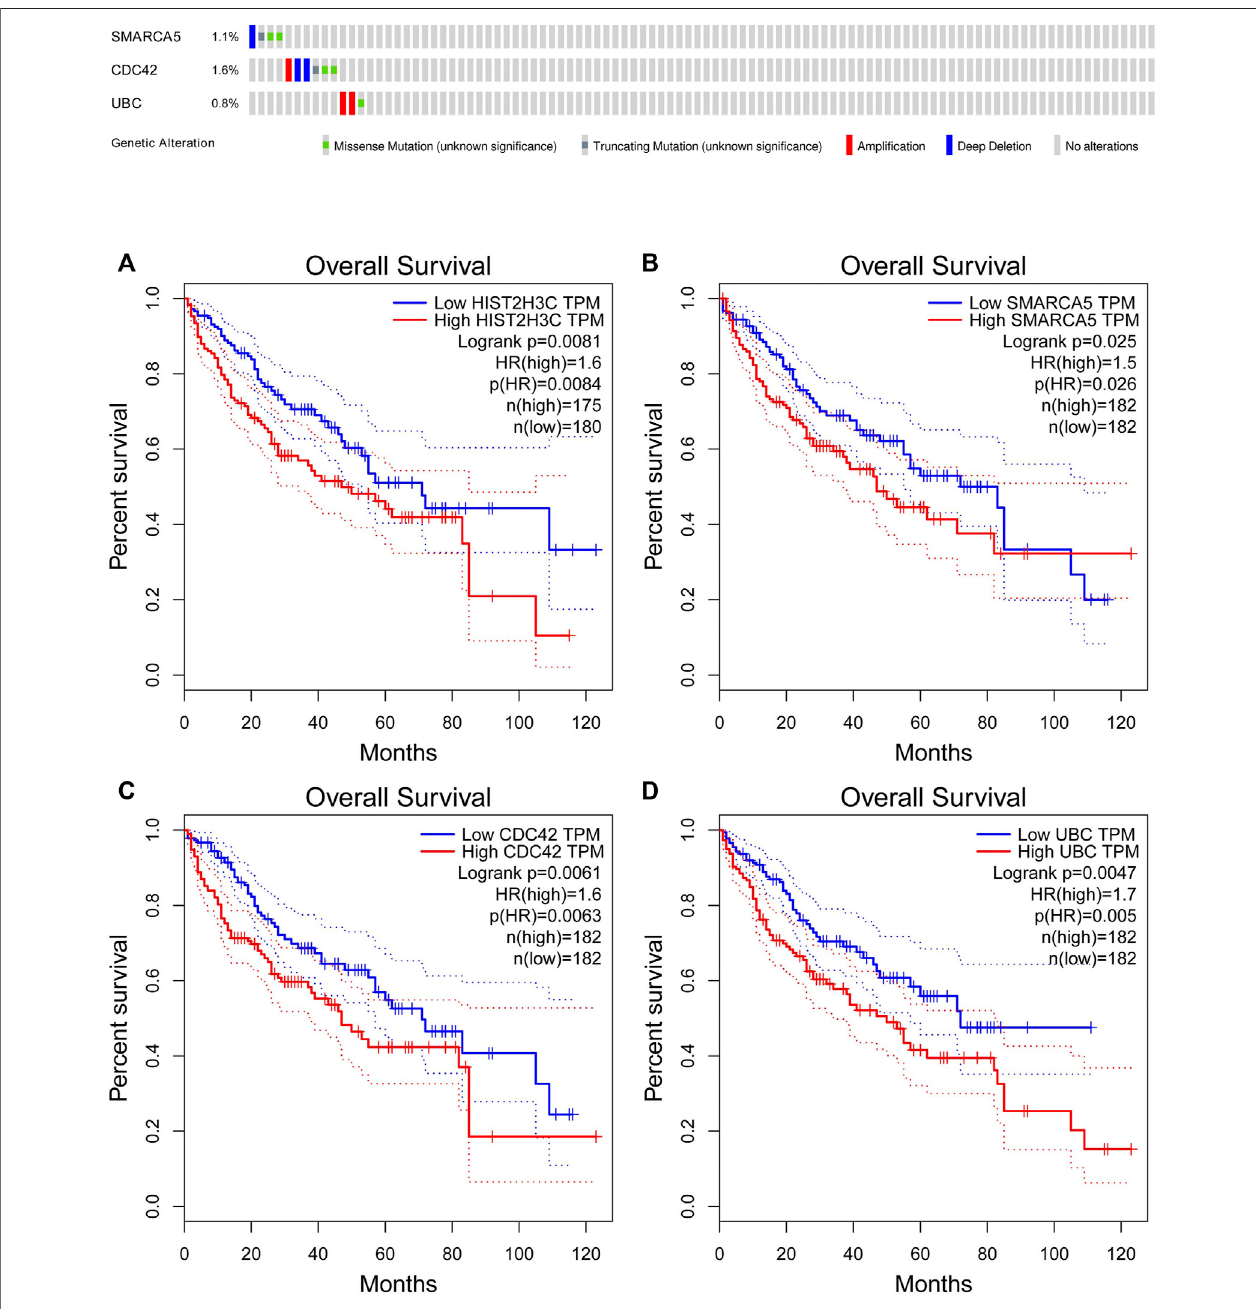
FIGURE 5 | cBioPortal genetic alterations and GEPIA overall survival results. (A) HIST2H3C; (B) SMARCA5; (C) CDC42; (D) UBC.